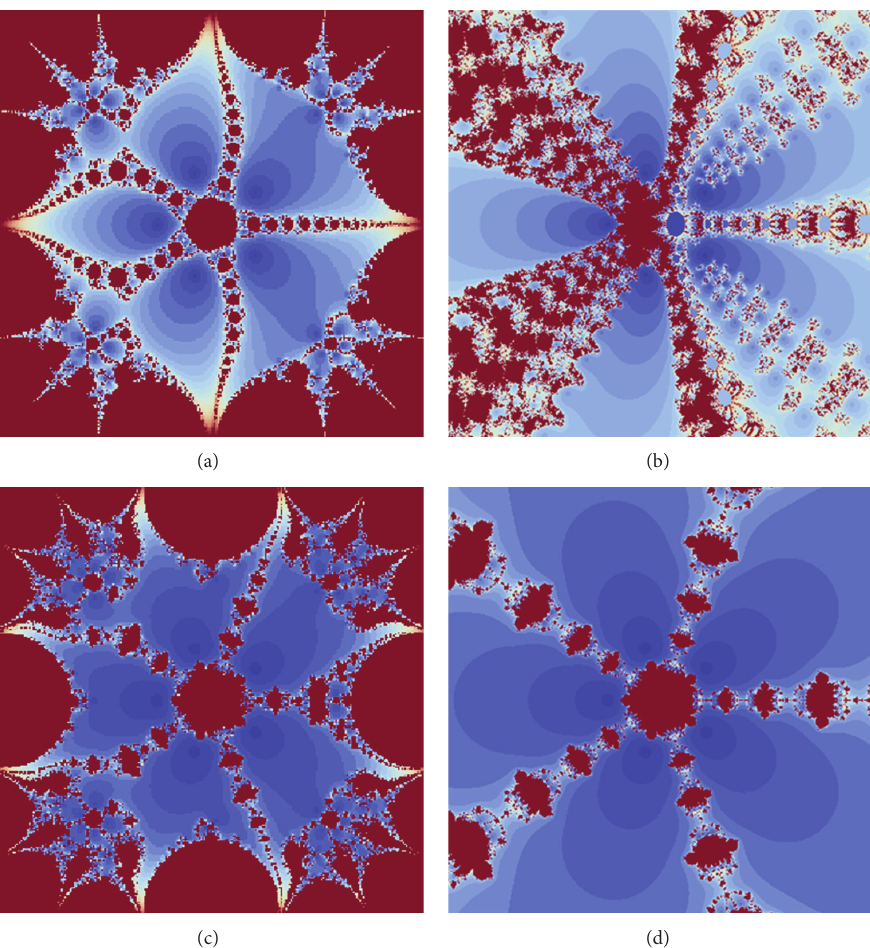
Figure 5: Fractal behavior for the rational function associated to the Steffensen’s method with 𝛽 = 0.01 (a), Jain’s method (b), (3) with 𝛽 = 0.01 (c) and (3) with 𝛽 = 0.0001 (d) for 𝑓 : 𝑧 → 𝑧 5 + 1 . Shading according to the number of iterations.